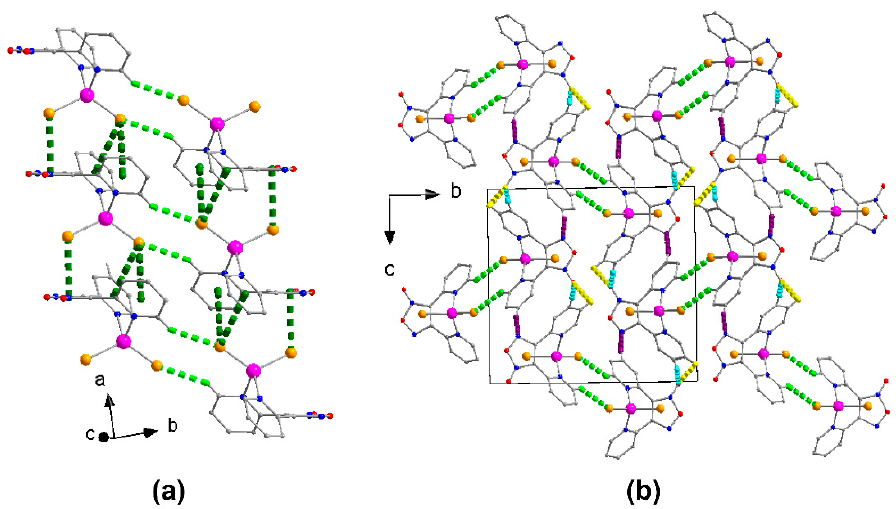
Figure 6. ( a ) A stack of hydrogen-bonded dimers of complex [ZnCl 2 (L)] ( 1 ) along the a axis, formed through Cl ··· π intermolecular interactions indicated with thick, green dashed lines. ( b ) View along the a axis illustrating the stacks of hydrogen-bonded dimers and their interactions through C10–H10 ··· O1, C11–H11 ··· O1 and C3–H3 ··· N3 interactions indicated with thick cyan, yellow and violet dashed lines, respectively. The intradimer C1–H1 ··· Cl1 interactions are presented with light green dashed lines, while the Cl ··· π interactions and the hydrogen atoms not involved in hydrogen bonds are not shown for clarity. Table 2. Selected bond lengths (Å) and angles ( ◦ ) for complex [ZnCl 2 (L)] ( 1 ). Bond Lengths (Å)